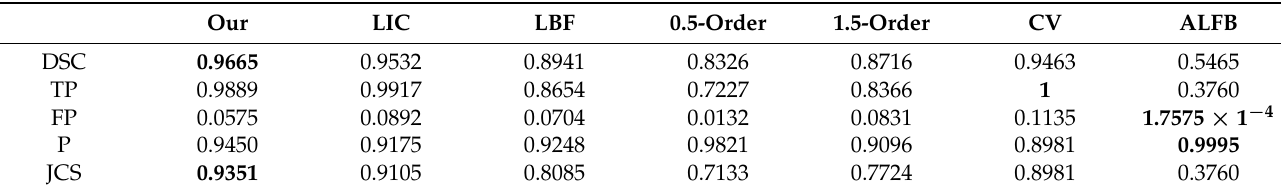
Table 1. The corresponding evaluation index values of Figure